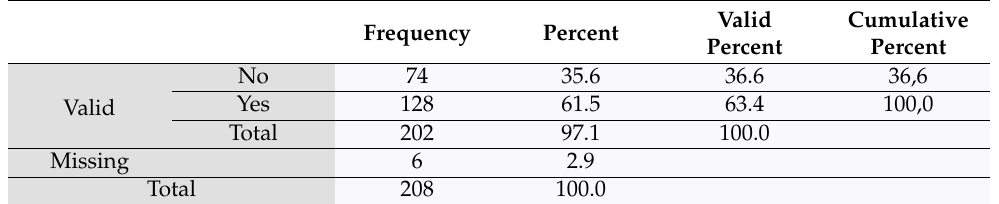
Table 5. Did you need the dentist during the pandemic?